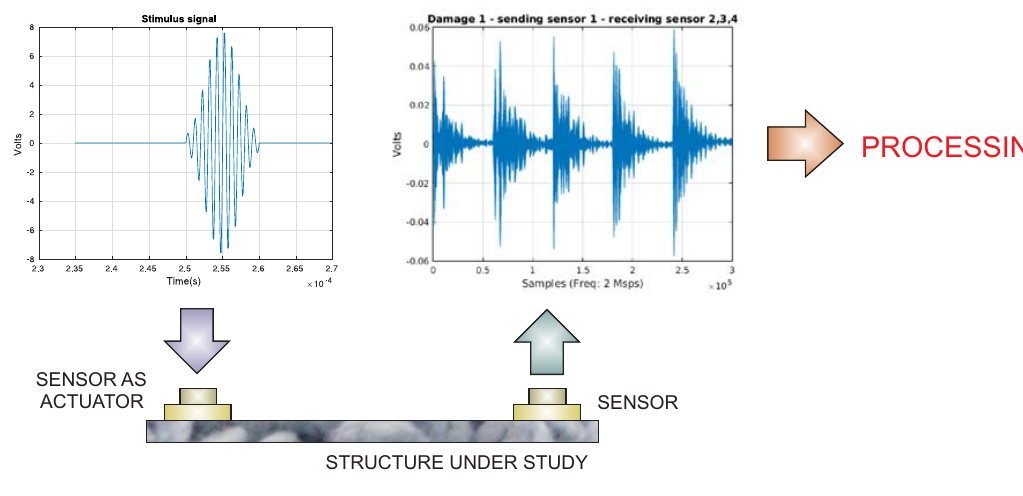
Figure 4. Signal